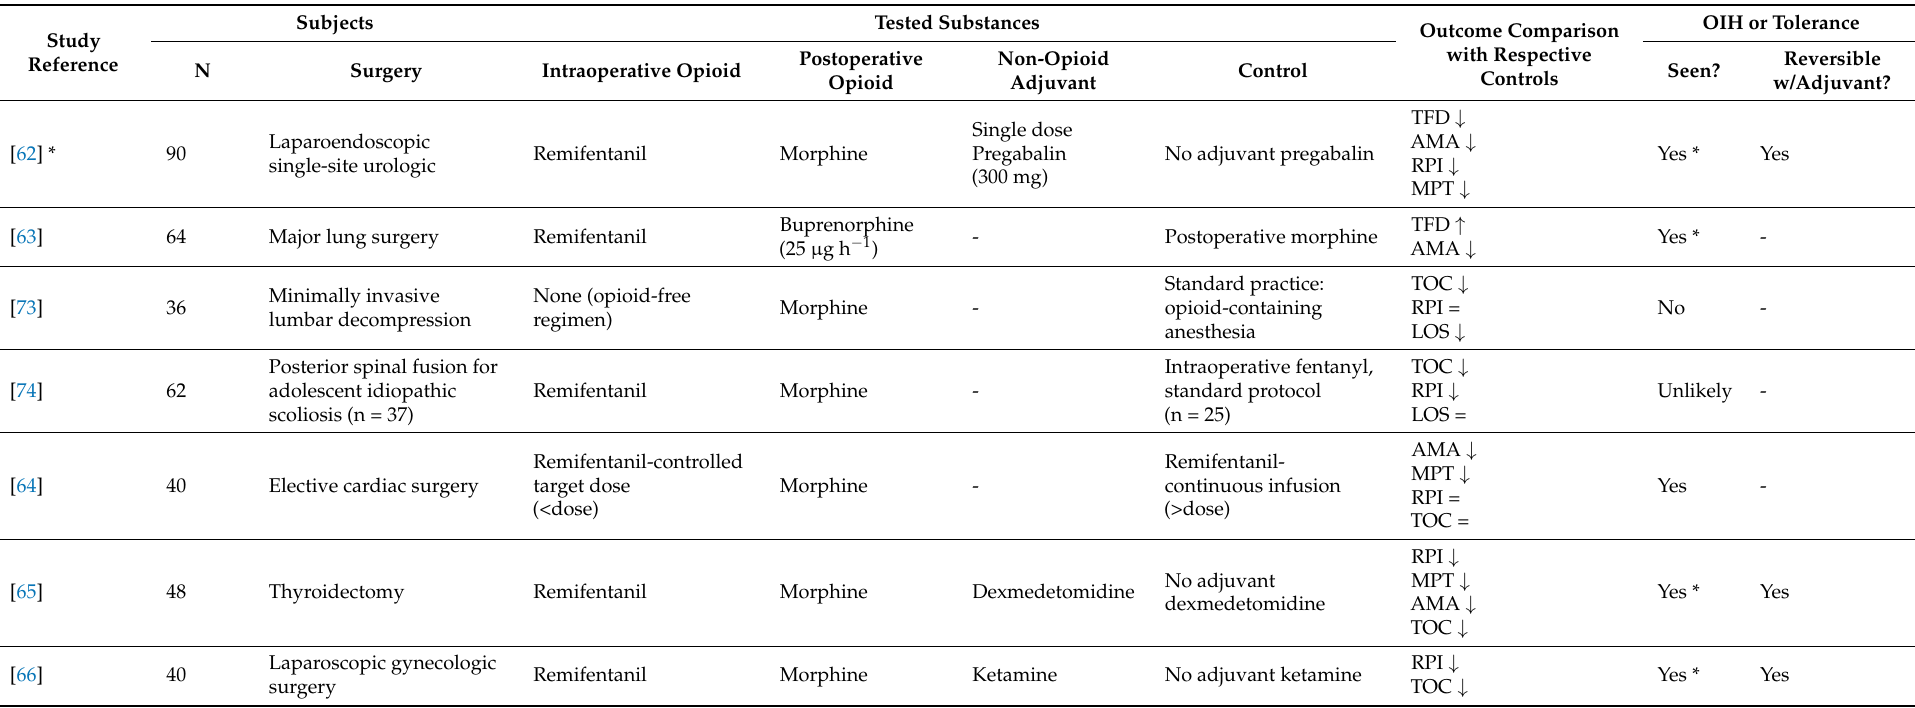
Table 2. Characteristics of relevant studies in surgical contexts of analgesia: setting, tested substance, patients, and